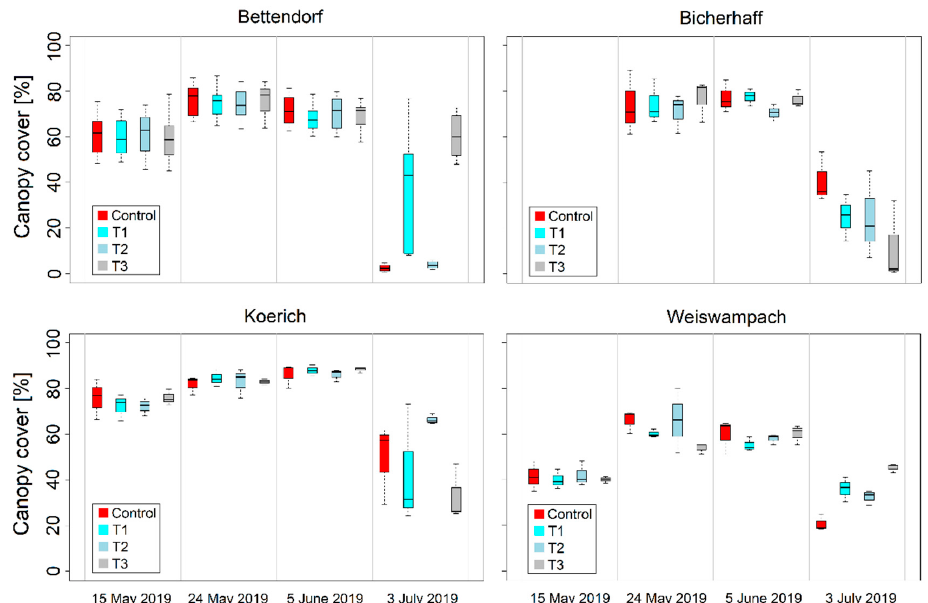
Figure 6. Estimated canopy cover during the monitoring period at the four experimental sites during the 2018-2019 growing season. Canopy cover values were calculated from unmanned aerial vehicle (UAV)-based Red-Green-Blue (RGB) imagery. T1, T2, and T3 refer to single, double, and triple fungicide-treated plots (Table 1); Control refers to the non-fungicide treated plots. The horizontal line represents the median value, surrounded by box edges presenting the 25th and 75th percentiles. The whiskers are the two lines outside of the box that extend to the highest and lowest data values. No data is available at Bicherhaff on 15 May 2019 since the images were blurry due to high velocity wind during the UAV flight.